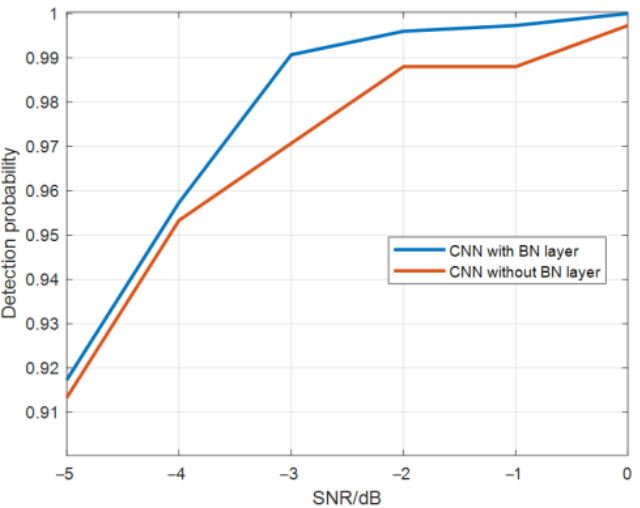
Figure 8. Target detection probability comparison graph of CNN with and without BN layer.